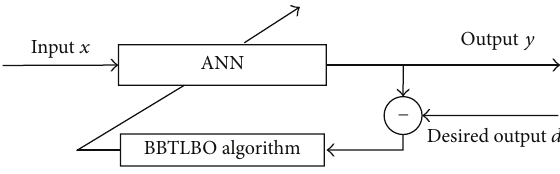
Figure 5: BBTLBO-based